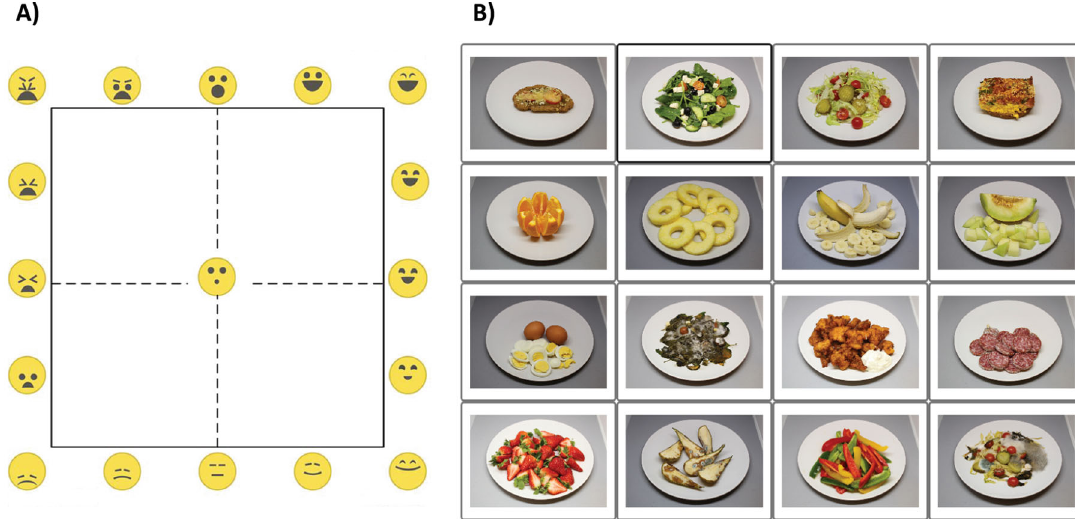
Fig. 1 Rating tool and stimuli. A EmojiGrid affective self-report tool used to rate valence (horizontal axis) and arousal (vertical axis) for each image. B Example images used in the present